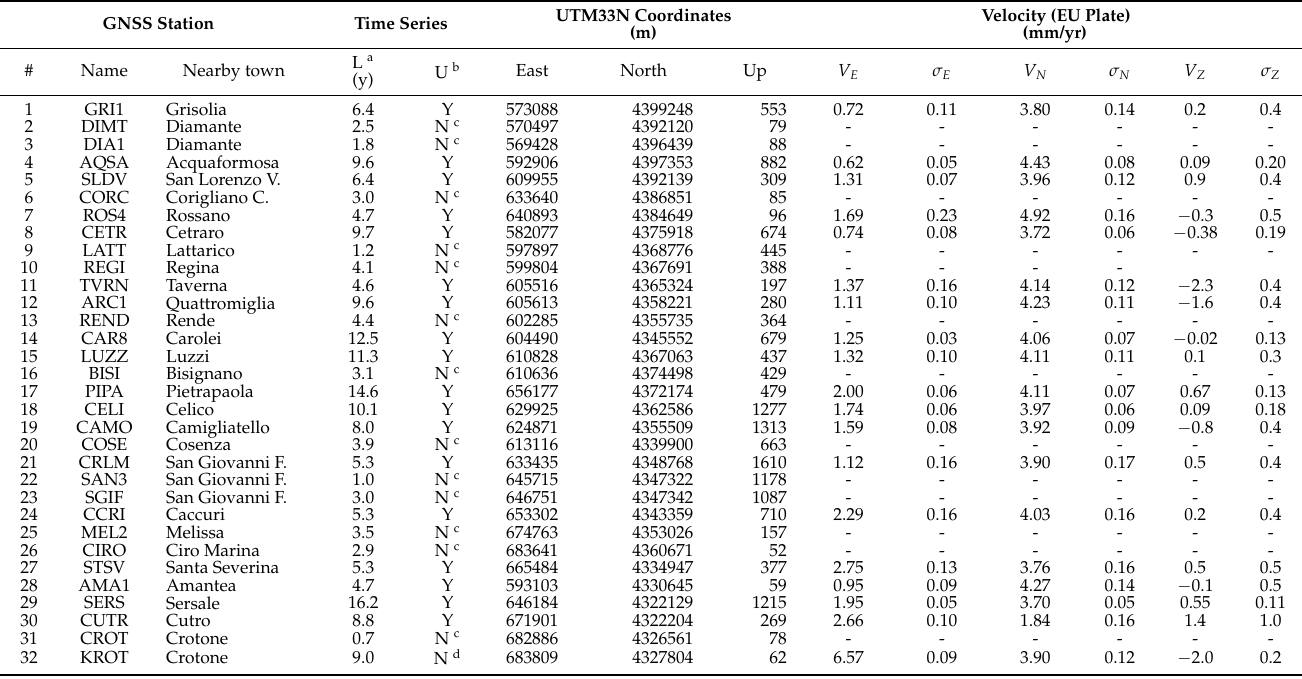
Table 3. Some data about GNSS stations in the studied area. More data are shown in Table S1 which can be downloaded as Supplementary